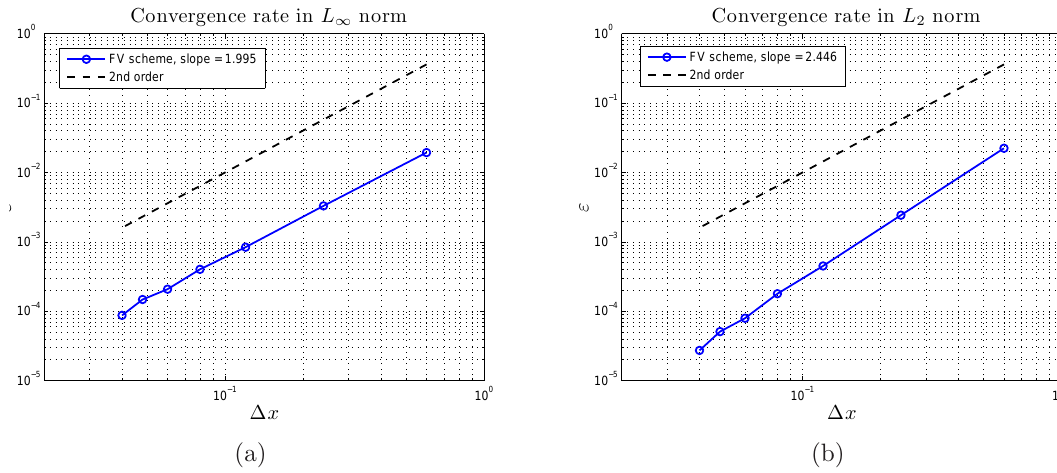
Fig. 8. Convergence rate of the finite-volume scheme in the L ∞ -norm (left panel) and the L 2 -norm (right panel). The numerical integration Figure 8. Convergence rate of the finite-volume scheme in the L ∞ -norm (left of a solitary wave as shown in Fig. 6 is compared to a translated profile. It appears that the second-order convergence is achieved. panel) and the L 2 -norm (right panel). The numerical integration of a solitary wave as shown in Figure We consider the linearized water wave problem for a fluid Table 1. Values of various parameters used to simulate the wave 6 is compared to a translated profile. generation by moving layer of uniform depth z = − d 0 = const. However, a por- It appears that the second-order convergence is achieved.